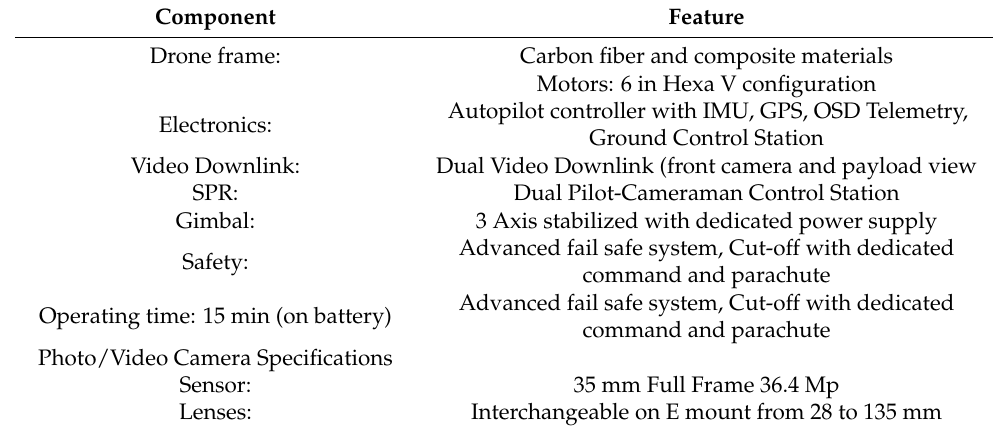
Table A1. Main features of AEROPIX